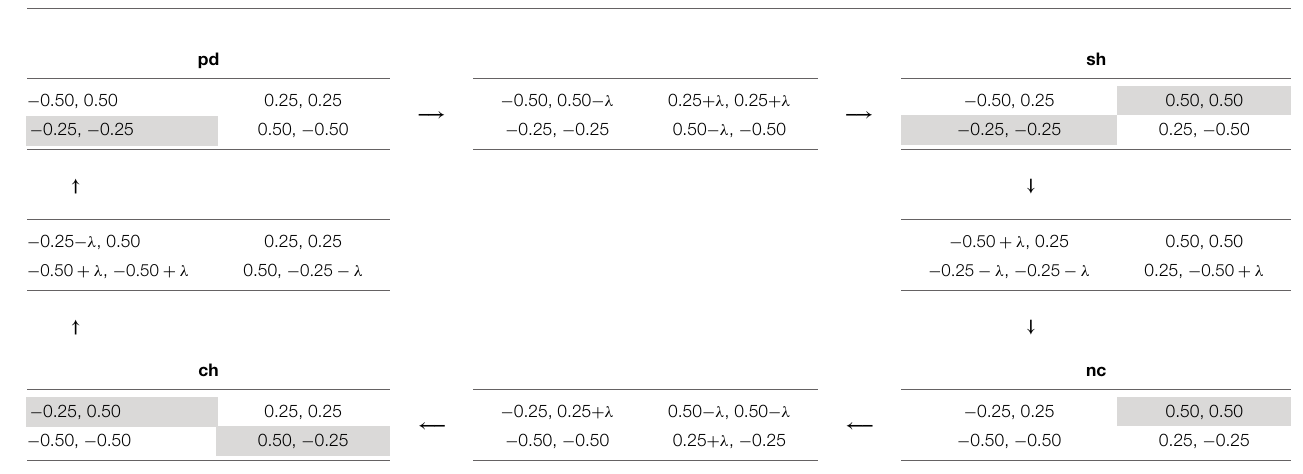
TABLE 9 | A sequence of games spanning four game